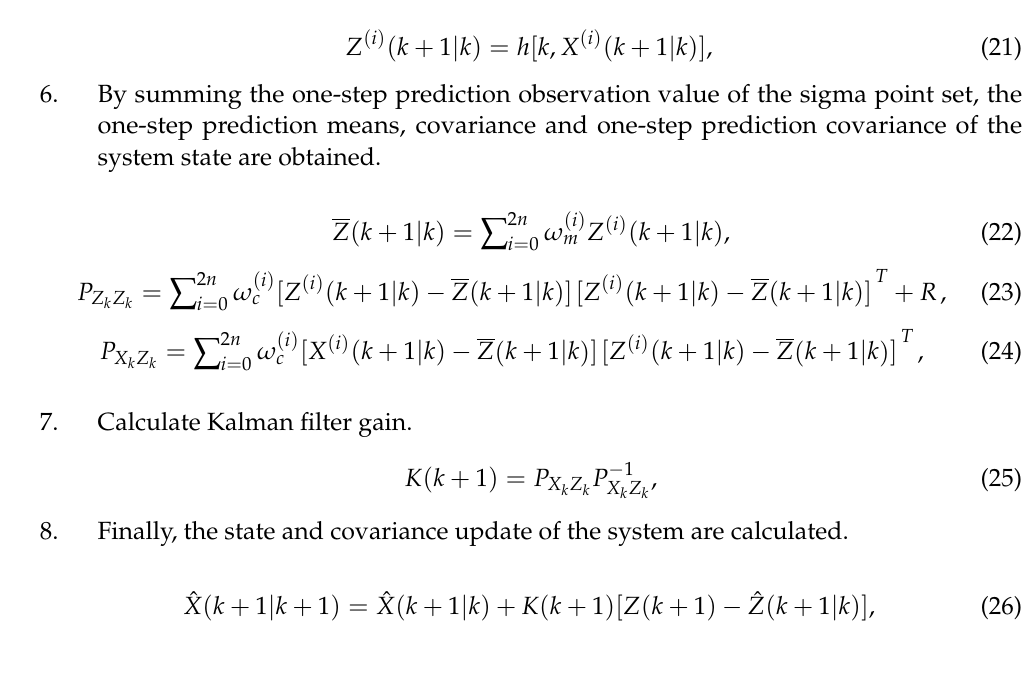
By substituting the new set of sigma points into the observation equation, the one-step predicted value of the observed quantity can be obtained, i = 1,2... 2 n + 1.